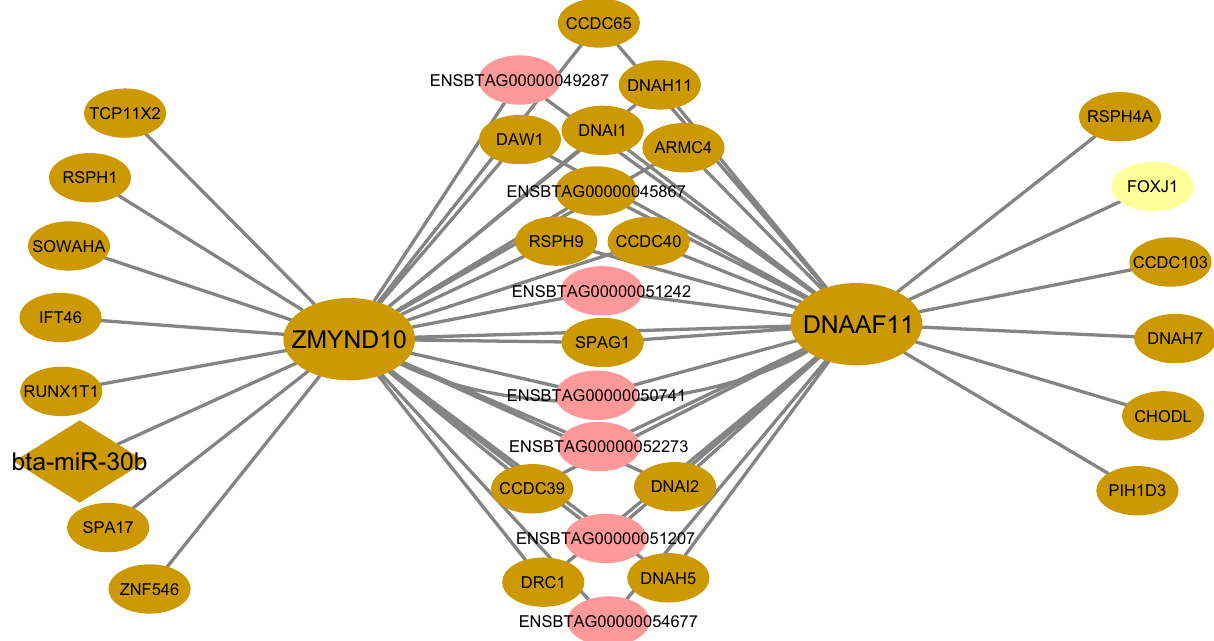
Figure 11. The constructed integrated regulatory sub-network related to ZMYND10 and DNAAF11 in brown Rb-module. The pink circles indicate hub-hub lncRNAs related to the mentioned genes. The brown diamond represents hub miRNA that be predicted to regulate ZMYND10 . The yellow circle indicates hub TF. Cytoscape software (version 3.7.2) (https:// cytos cape. org/) was used to generate this Figure.